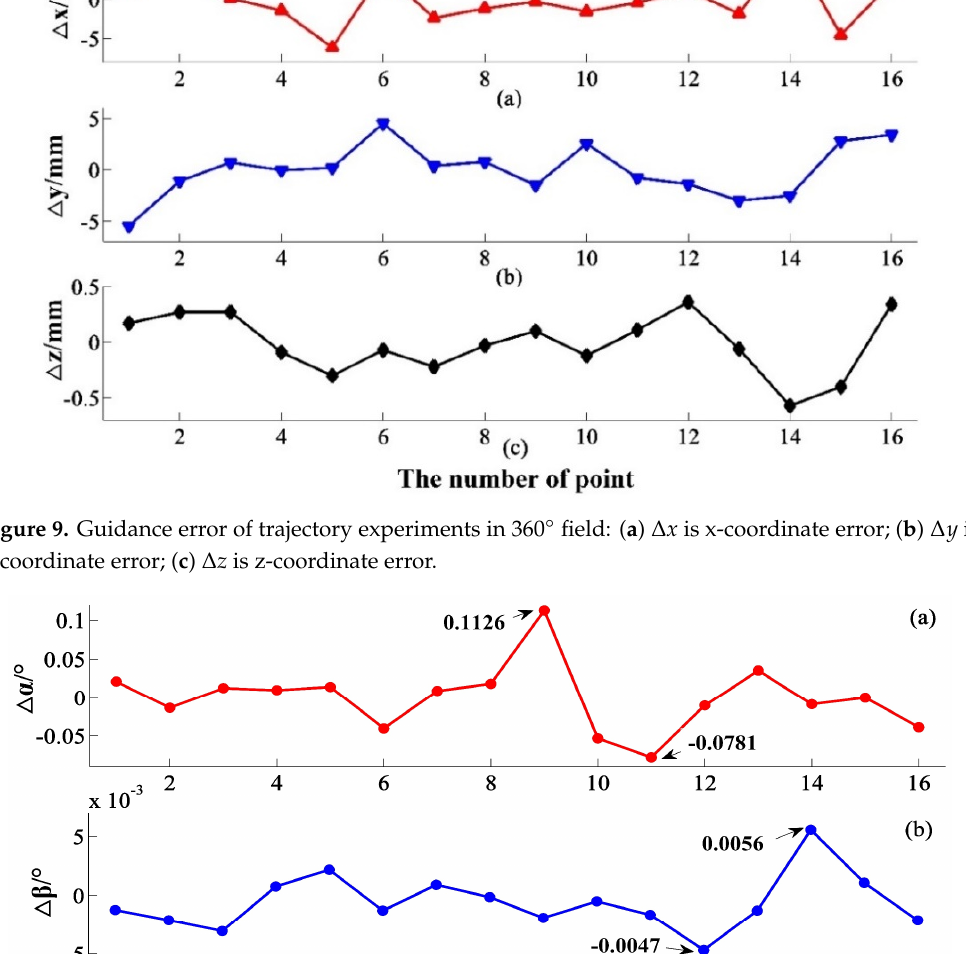
Figure 10. Guidance angle error of trajectory experiments in 360 ◦ field: ( a ) ∆ α is the horizontal angle error; ( b ) ∆ β is the vertical angle error. Table 3. Coordinate value and deviation of 360° guidance experiment.